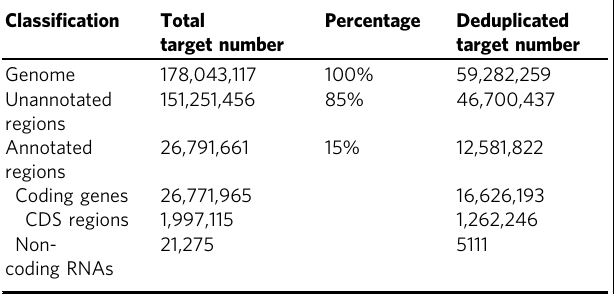
Total target number: all Targets of Crocus sativus ; Deduplicated target number: Targets after removing duplicates; Genome: Targets located in the whole genome; Unannotated regions: Targets located in the unannotated regions of genome; Annotated regions: Targets located in the annotated regions of genome; Coding genes: Targets located in coding genes of Cr. sativus ; CDS: Targets located in CDS of Cr. sativus ; Non-coding RNAs: Targets located in miRNA, rRNA, snRNA or